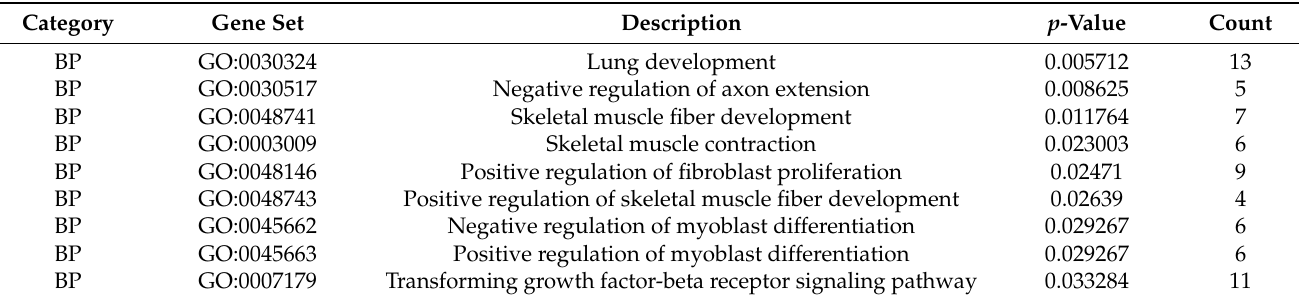
Table 3. Biological processes associated with skeletal-muscle-maturation- and hypertrophy-related DEGs in Bos taurus .